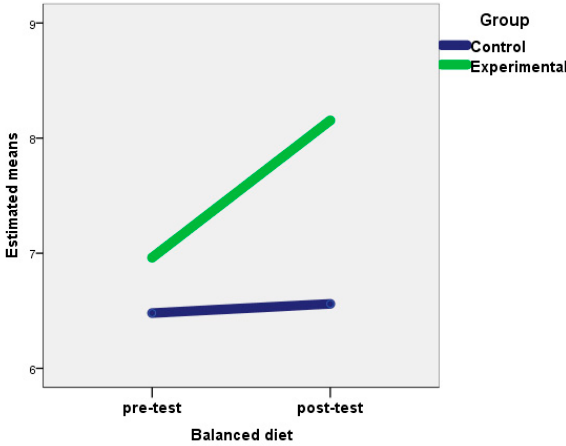
Figure 2. Changes in balanced diet for the experimental and control groups after the intervention.